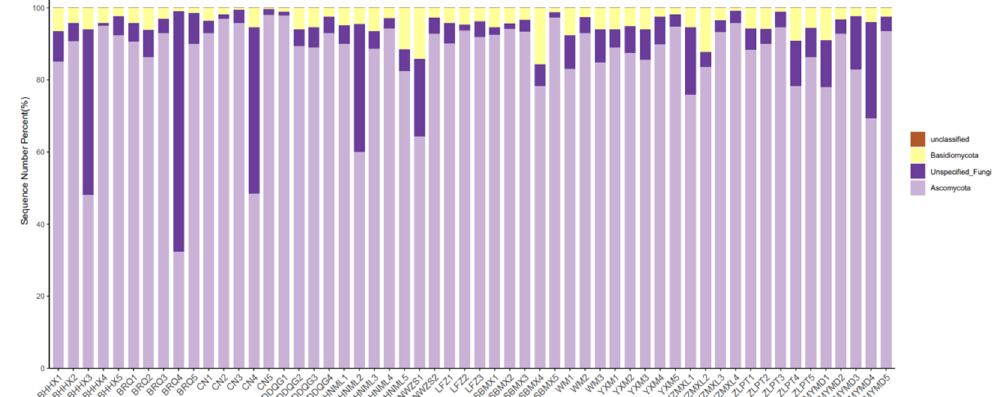
Figure 3. Relative abundance at phylum level of fungal communities in the samples.